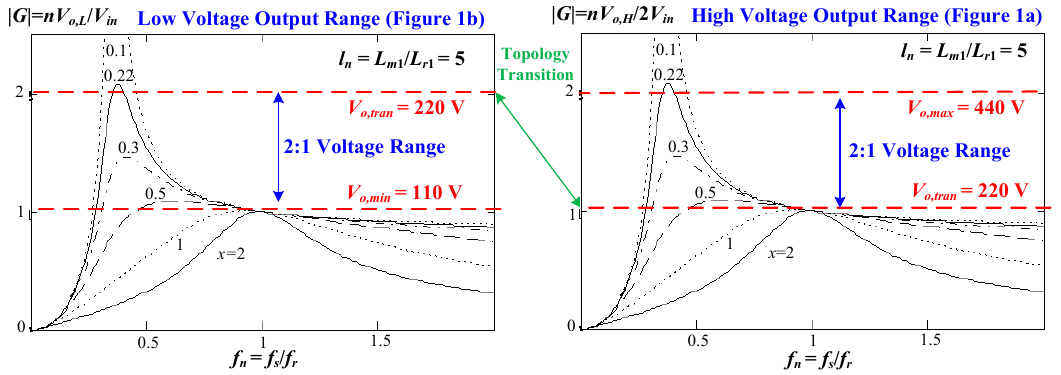
( b ) Figure 5. Control block of voltage transition operation. ( a ) Schmitt comparator; and ( b ) control block of signals S 1 ~ S 8 . 4. Experimental Verification A laboratory prototype (Figure 6) was constructed and tested. The circuit parameters are calculated from the previous section. The test waveforms are demonstrated and shown to confirm the theoretical discussion and effectiveness of the studied circuit with a wide output voltage range. Figures 7 and 8 provide the experimental results under low-voltage range with only one resonant converter operation. Figure 7 demonstrates the experimental waveforms for V o = 110 V and P o = 1 kW. The experimental waveforms of v S 1, g ~ v S 4, g are given in Figure 7a. The switching frequency of S 1 ~ S 4 is about 100 kHz. The leg voltage v ab and the resonant component waveforms v Cr 1 and i Lr 1 are provided in Figure 7b. v Cr 1 and i Lr 1 are almost sinusoidal waveforms due to f s ≈ f r . The inductor current i Lr 1 is lagging to the measured voltage v ab . The input impedance of the resonant tank by C r 1 , L r 1 , L m 1 , and R ac 1 is operated at the inductive load. Figures 7c,d provide the measured diode currents. It is obvious that D 1 ~ D 4 turn off under zero current. There is a slight current imbalance on D 5 and D 7 due to the unequal